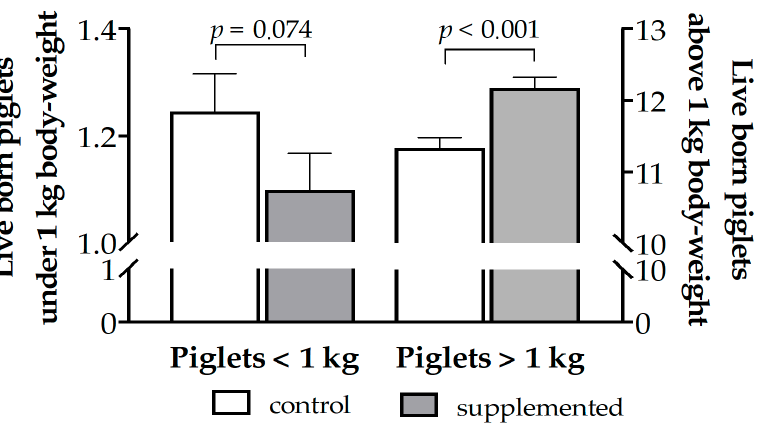
Figure 5. Mean number (± S.E.M.) of piglets under and above 1.0 kg of birth weight in sows treated or not with herbal antioxidants.